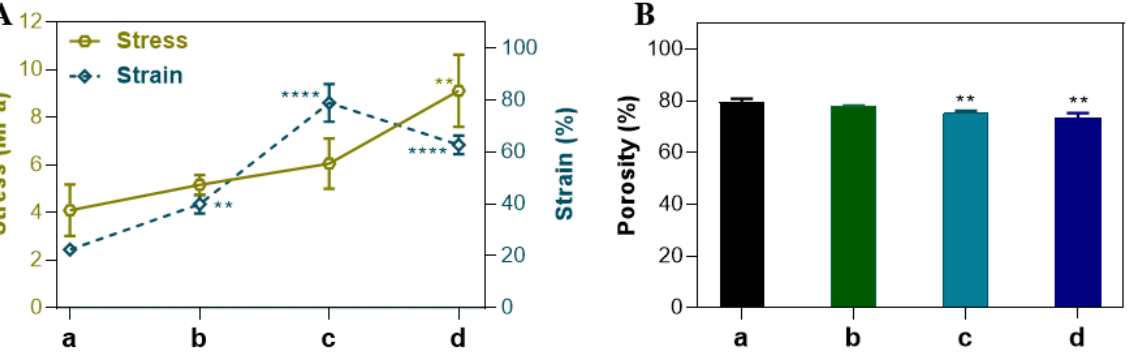
Figure 4. ( A ) Mechanical properties and ( B ) porosity% of (a) Pure-S1; (b) nCeO 2 -S1; (c) CEO/nCeO 2 - S3; (d) and CEO/nCeO 2 -S4. Data are expressed as average ± SD. ** p < 0.0021 , **** p < 0.0001, versus